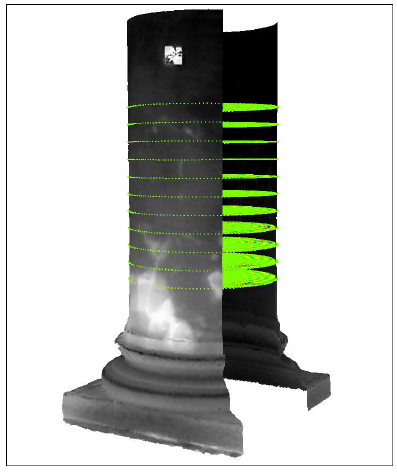
Figure 11. Integration of thermal-textured mesh and GPR grid data for the bottom part of the column.